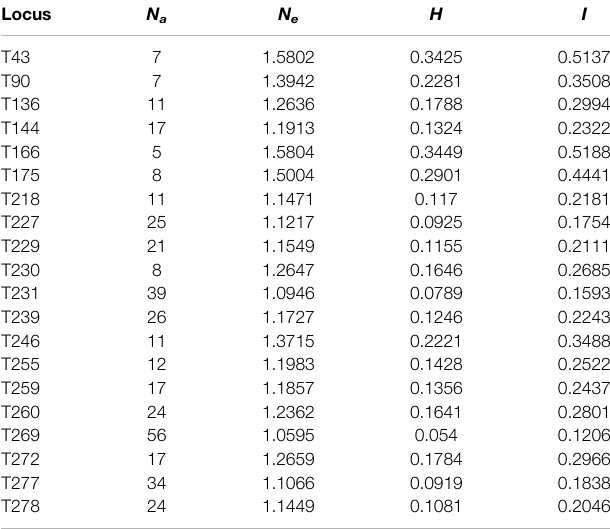
TABLE 4 | Genetic diversity parameters of the six populations of Schizothorax biddulphi .